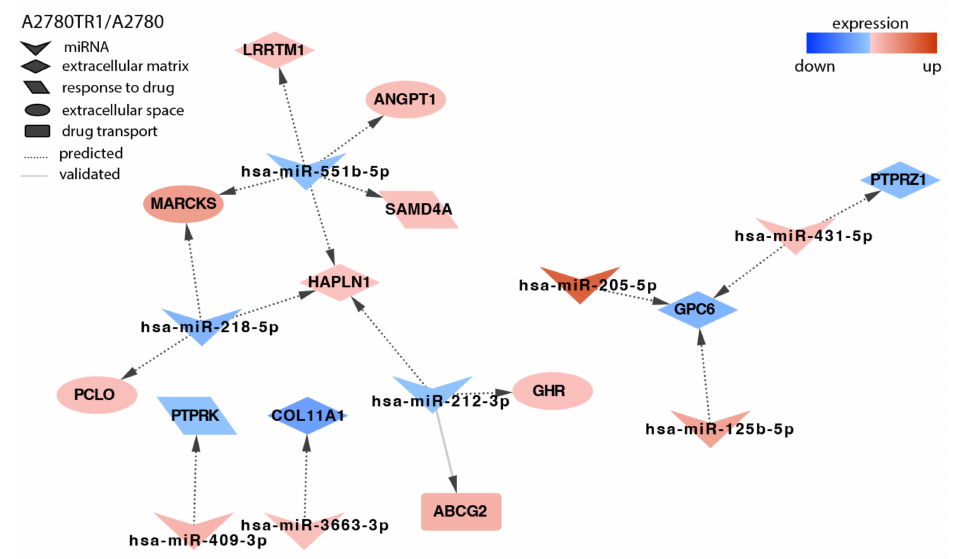
Figure 5. Regulation of selected target genes by miRNAs in the A2780TR1 cell